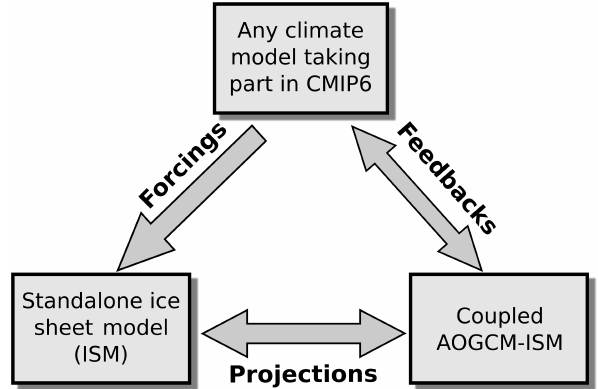
Figure 1. Overview of the ISMIP6 effort designed to obtain forcing from climate models, project sea-level contributions using ice-sheet models, and explore ice-sheet–climate